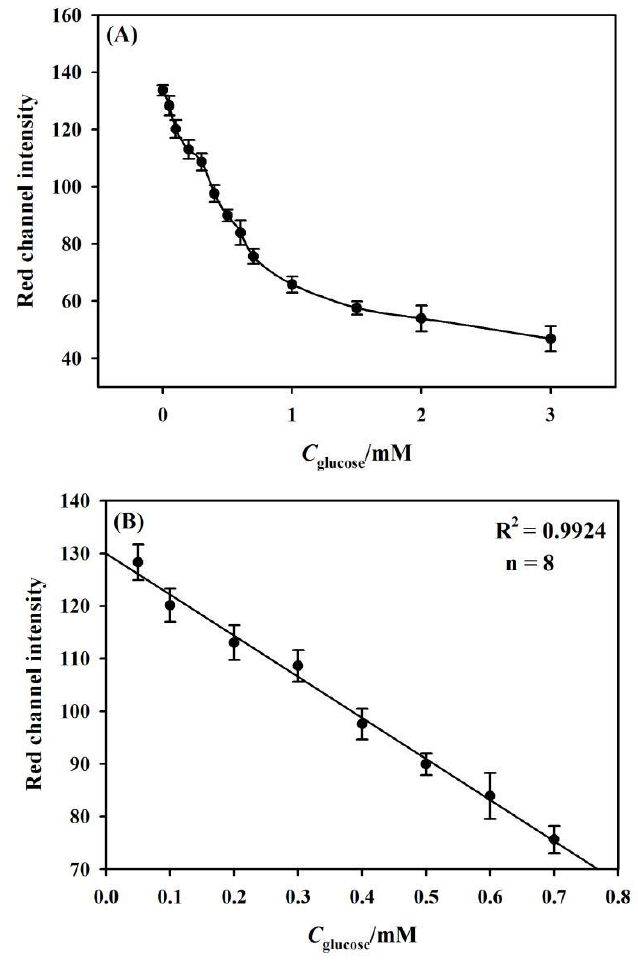
Figure 8. ( A ) Dependence of Red channel intensity on nitrite concentration. The concentrations are 0, 0.05, 0.1, 0.2, 0.3, 0.4, 0.5, 0.6, 0.7, 1.0, 1.5, 2.0, and 3.0 mM. ( B ) The linear fit plot of Red channel intensity and glucose from 0.05 mM to 0.7 mM. Table 2. Comparison of the parameters achieved for glucose assay performed on sensors found in literature.